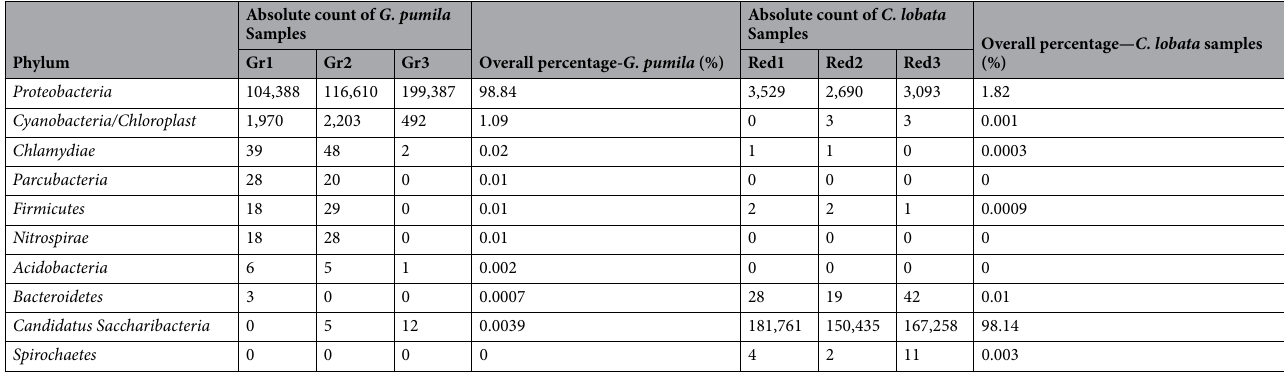
Table 2. Absolute count and overall percentage of bacterial phyla present in Gelliodes pumila and Cliona lobata samples.